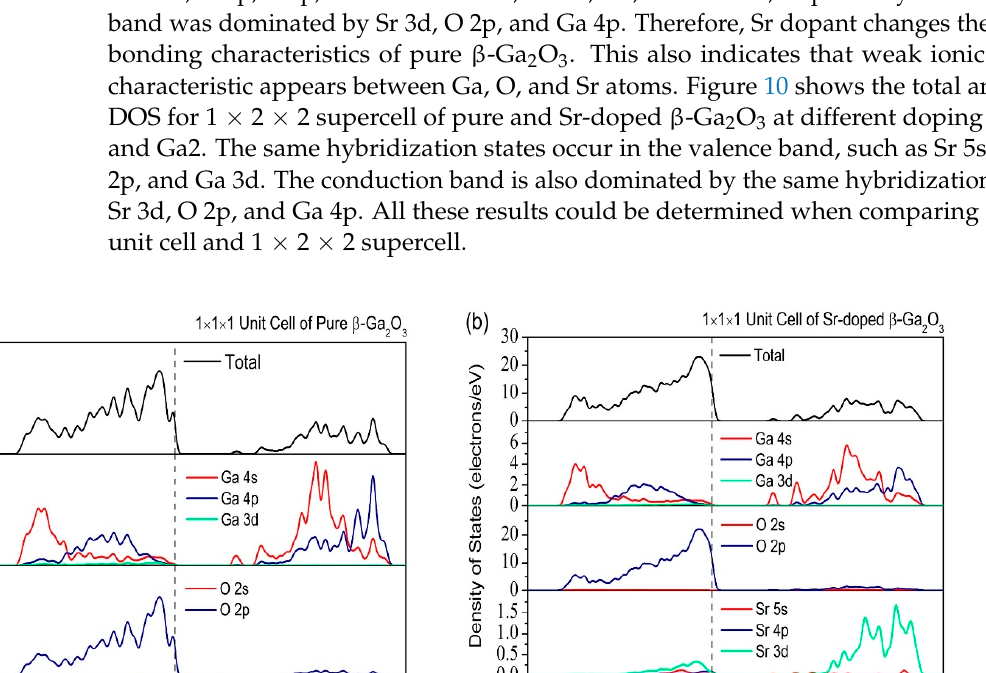
Figure 10. Total and Partial density of states of ( a ) pure β -Ga 2 O 3 , ( b ) Sr-doped β -Ga 2 O 3 at Ga1, and ( c ) Sr-doped β -Ga 2 O 3 at Ga2 in 1 × 2 × 2 supercell.